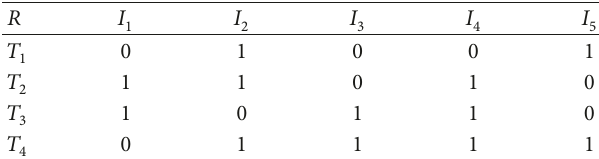
Table 2: A Boolean